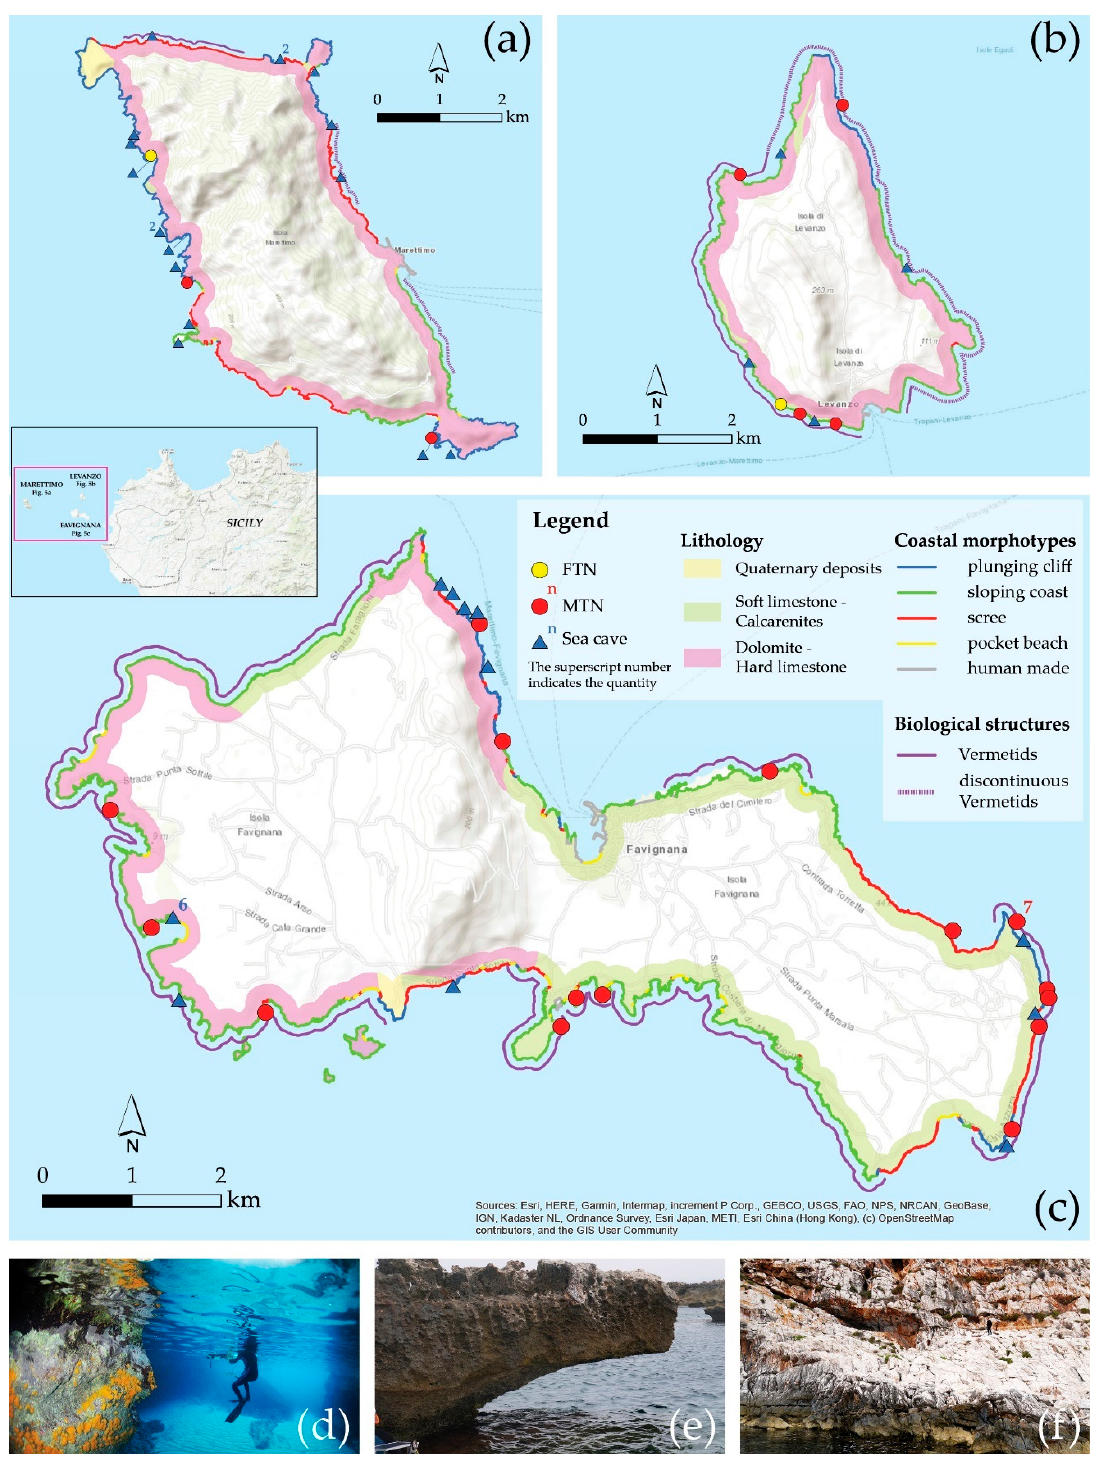
Figure 5 . Maps of coastal morphotypes and the surveyed geomorphological and biological structures at ( a ) Marettimo, ( b ) Levanzo, and ( c ) Favignana; ( d ) Grotta della Pipa at Marettimo, ( e ) MTN at Favignana, and ( f ) FTN at Levanzo.